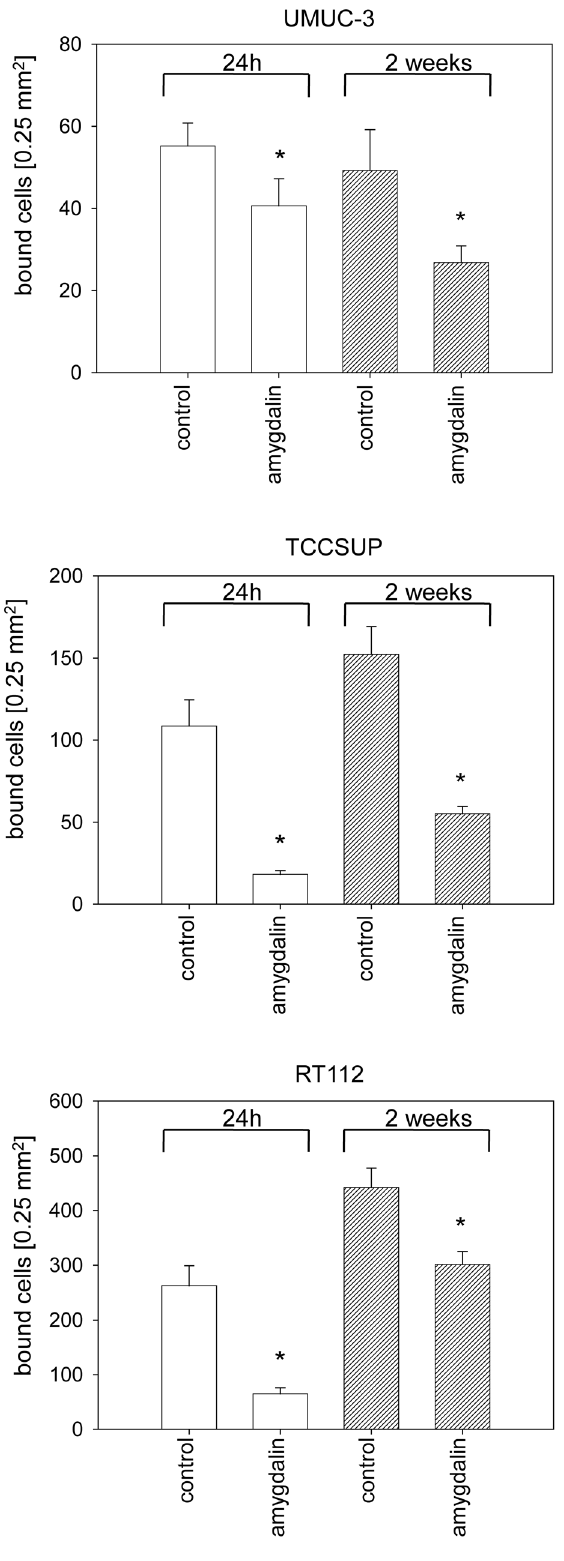
Figure 2. Adhesion of UMUC-3, TCCSUP and RT112 bladder cancer cells to immobilized collagen. Tumor cells were treated with 10 mg/ml amygdalin for either 24 h or for 2 weeks. Cells not treated with amygdalin served as the controls. 0.5 6 10 6 cells/well were added to immobilized collagen for 60 min. Mean number of